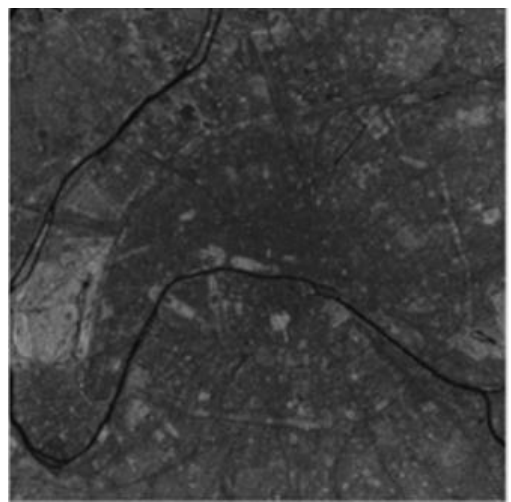
Figure 10. The image of the analyzed area in the near-infrared band.